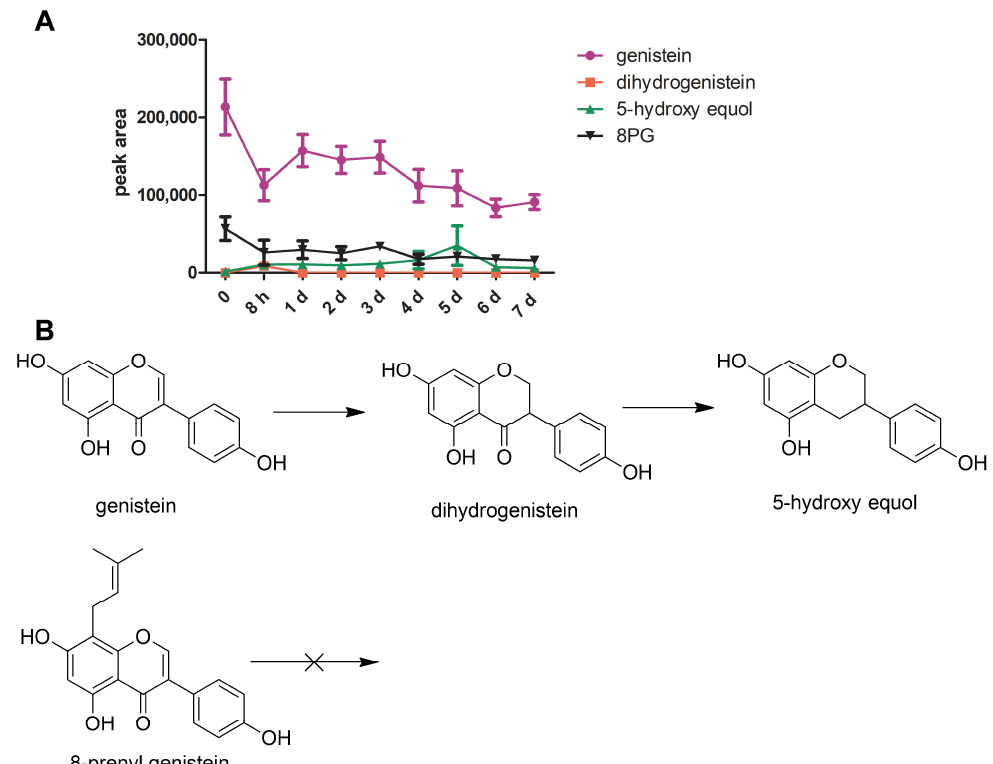
Figure 3. Time course of genistein and 8-prenyl genistein (8PG) conversion by rat-gut bacteria during 7 days. ( A ) Genistein ( ● ) was transformed via dihydrogenistein ( ▪ ) to 5-hydoxy equol ( ▲ ), while no detectable metabolites of 8PG were identified; ( B ) the transformation pathway of genistein and 8PG. The symbols indicate the means of triplicate experiments. The error bars indicate standard error of mean.